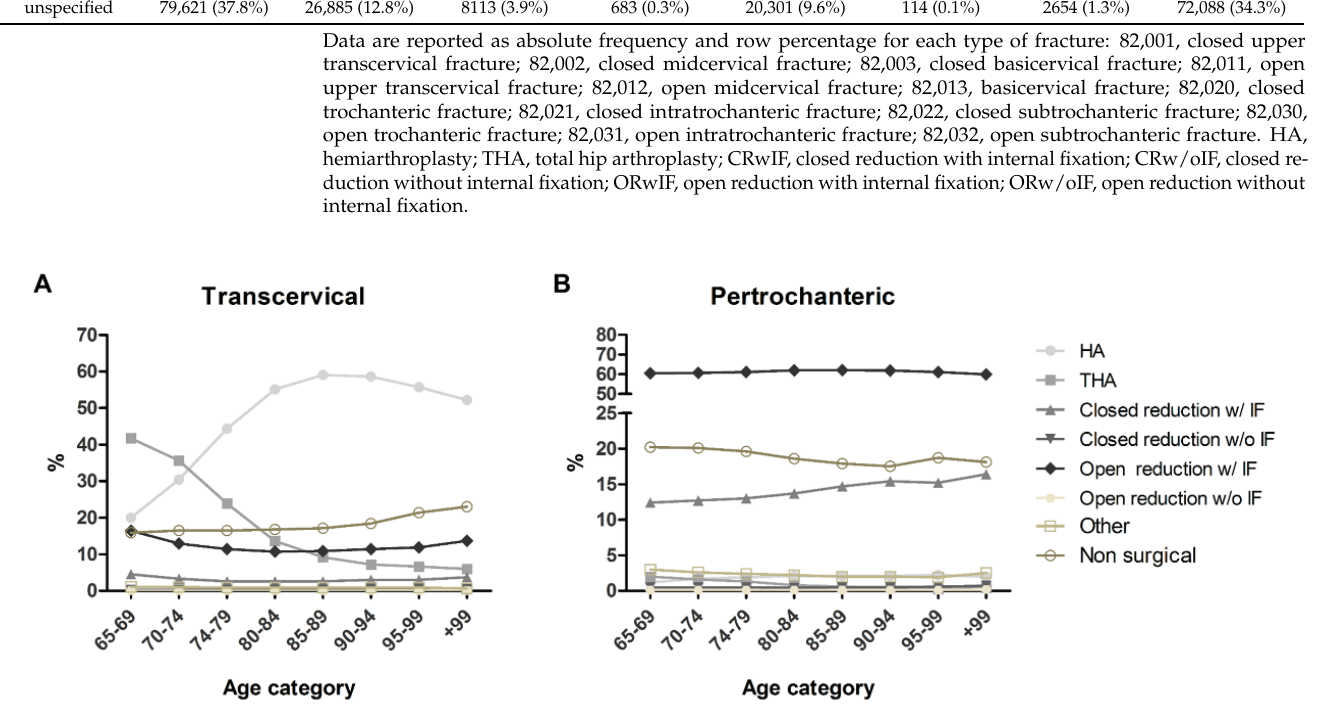
Figure 4. Relative frequency of treatments for transcervical ( A ) and pertrochanteric ( B ) fractures in different age categories. HA, hemiarthroplasty; THA, total hip arthroplasty; w/ IF, with internal fixation; w/o IF, without internal fixation.